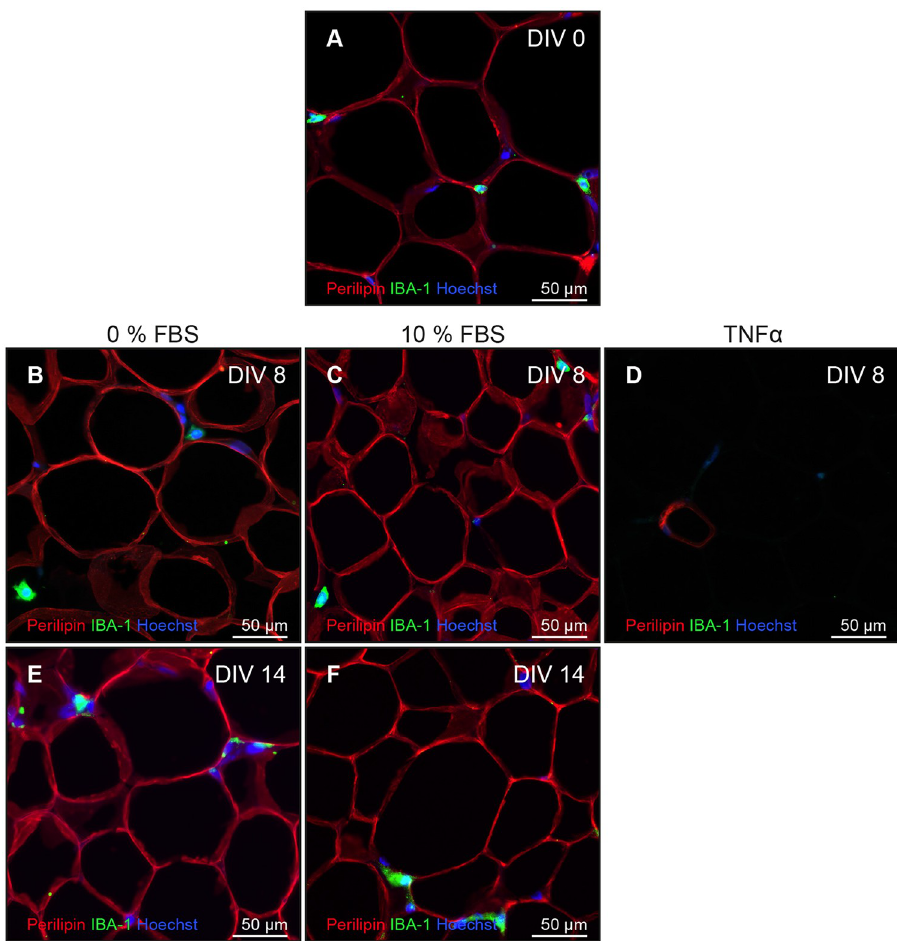
Fig 4. Viability of adipose cells. Viability was determined via immunofluorescence and insulin stimulation. Antibodies against Perilipin (red) and monocytes were shown with IBA1 (green). Cell nuclei were counterstained (Hoechst 33342, blue). A—0 th DIV. B to D—8 th DIV. E & F—14 th DIV. Left column—0 % FBS. Middle column—10 % FBS. Right column—human TNF α .